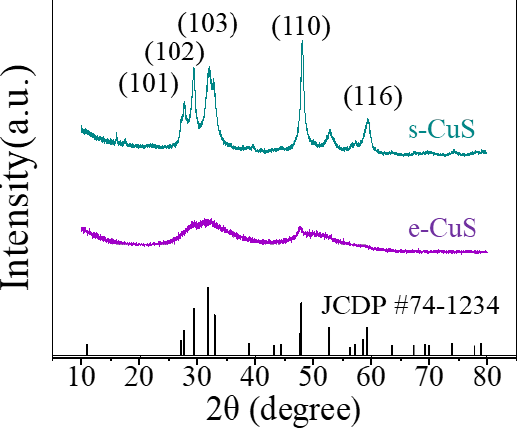
Figure 2. The XRD patterns of c-CuS and s-CuS.